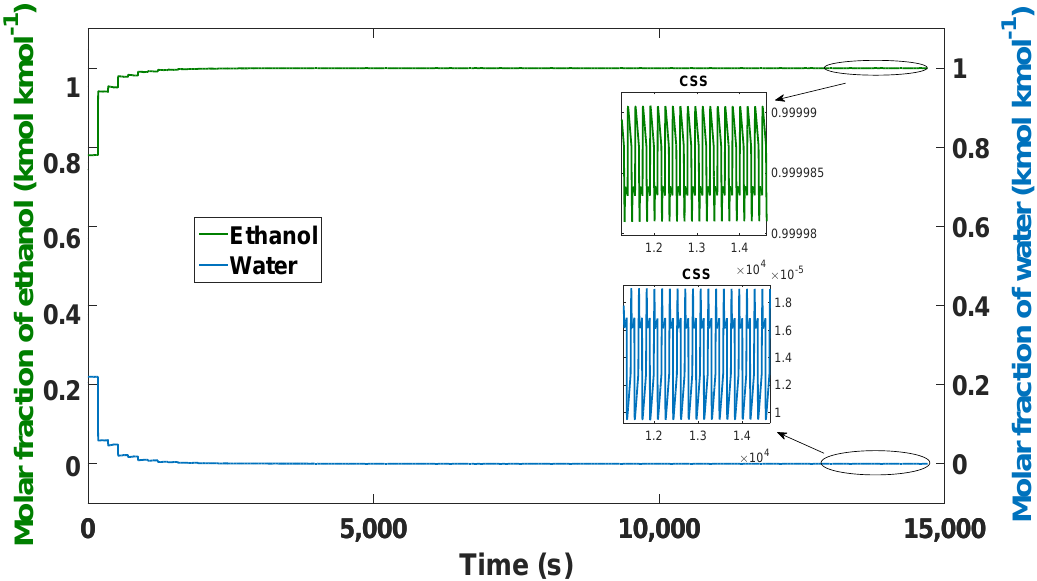
Figure 9. Ethanol–water mixture purity profile, process from boot to